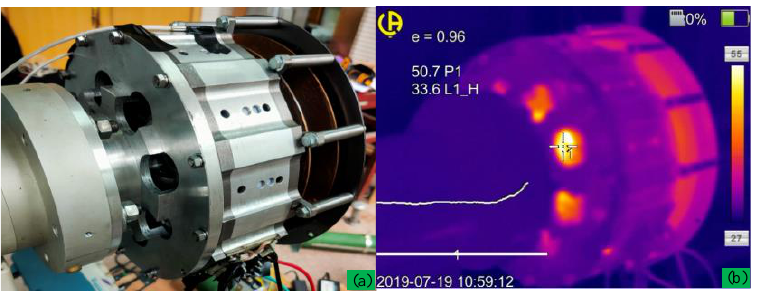
Figure 29. Driving end view of ISG and its thermal image at n = 3000 rpm ( a ) driver side view, ( b ) thermal imaging figure.